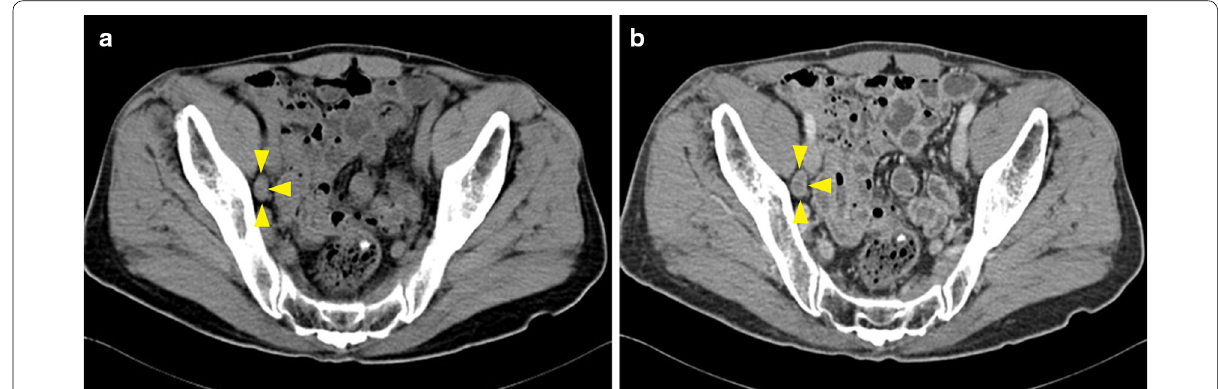
Fig. 3 Pelvic computed tomography (CT) images of a 76-year-old man with bladder cancer (stage pT3a). a CT scan before contrast shows an isodensity oval lymph node with a short-axis diameter of 9.0 mm in the right obturator region (yellow arrows). b In the vein phase after contrast, the necrosis in the center of the lymph node shows annular enhancement (yellow arrows). This lymph node with necrosis was proved to be metastatic in pathologic diagnosis